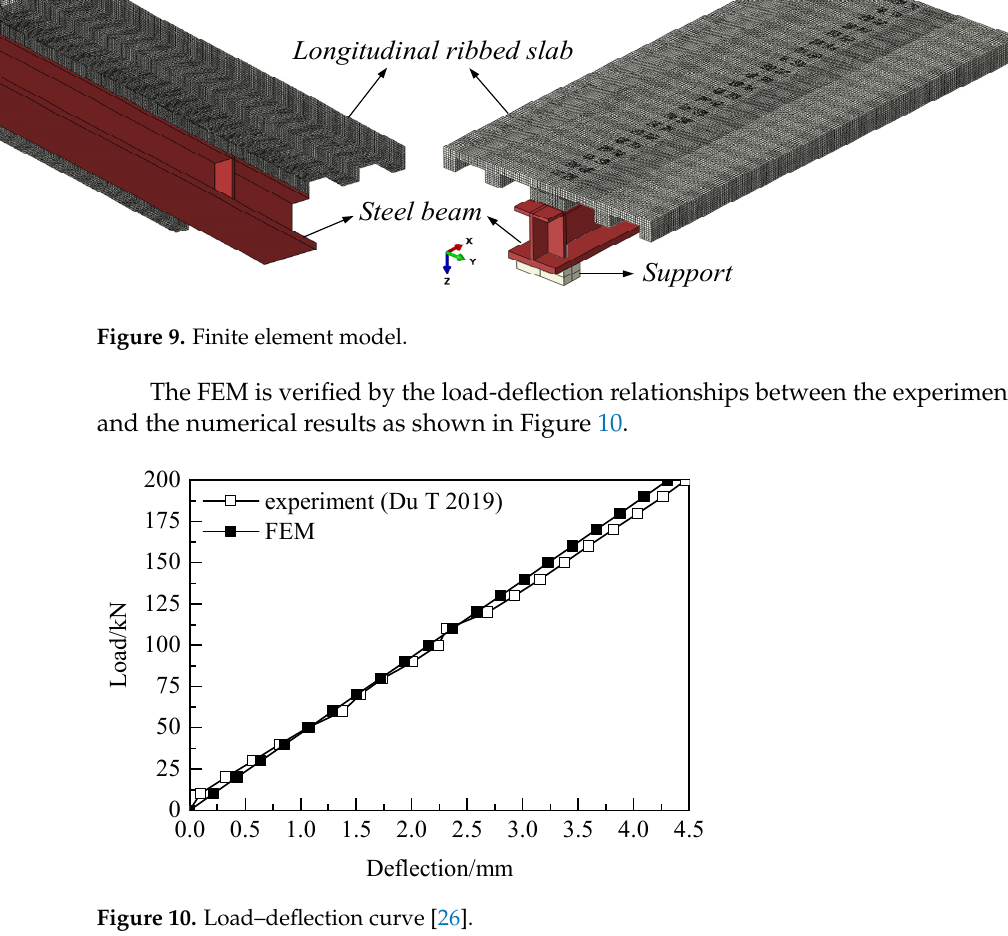
Figure 8. Dimension of SU-LRSCS specimen (unit: mm): ( a ) elevation; ( b ) cross section; ( c ) simplified structure.